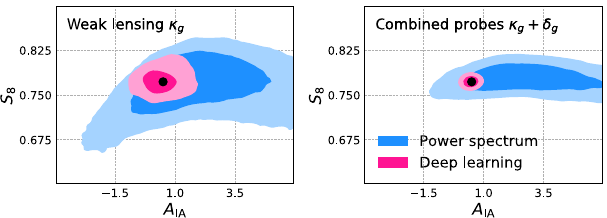
FIG. 4. Constraints on S 8 , intrinsic alignments A evolution η , for the combined probes (left) and lensing only A IA (right), using the linear galaxy bias model.